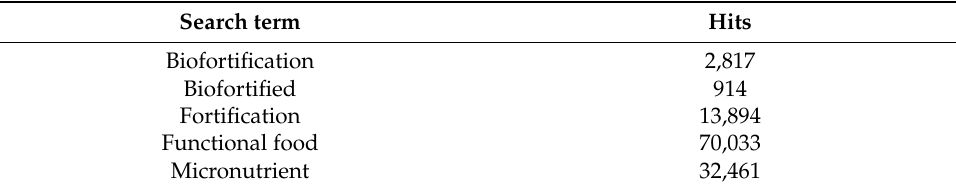
Table 1. Number of papers published by year. Search